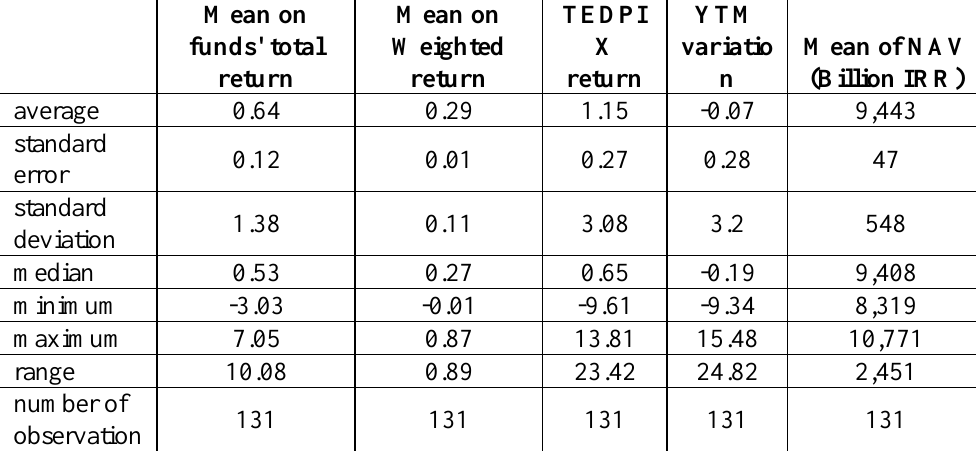
Table 2. Descriptive Statistics of